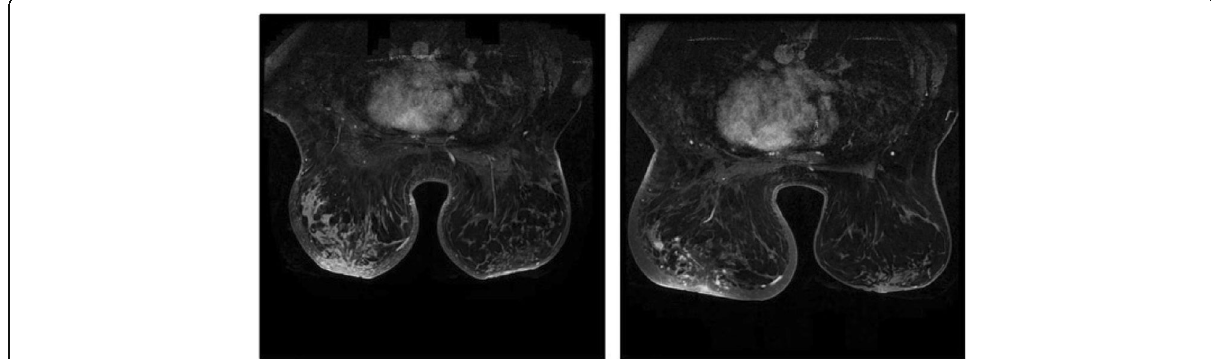
Fig. 3 Diffused tumors enhanced in breast MRI performed before (left image) and after (right image) neoadjuvant